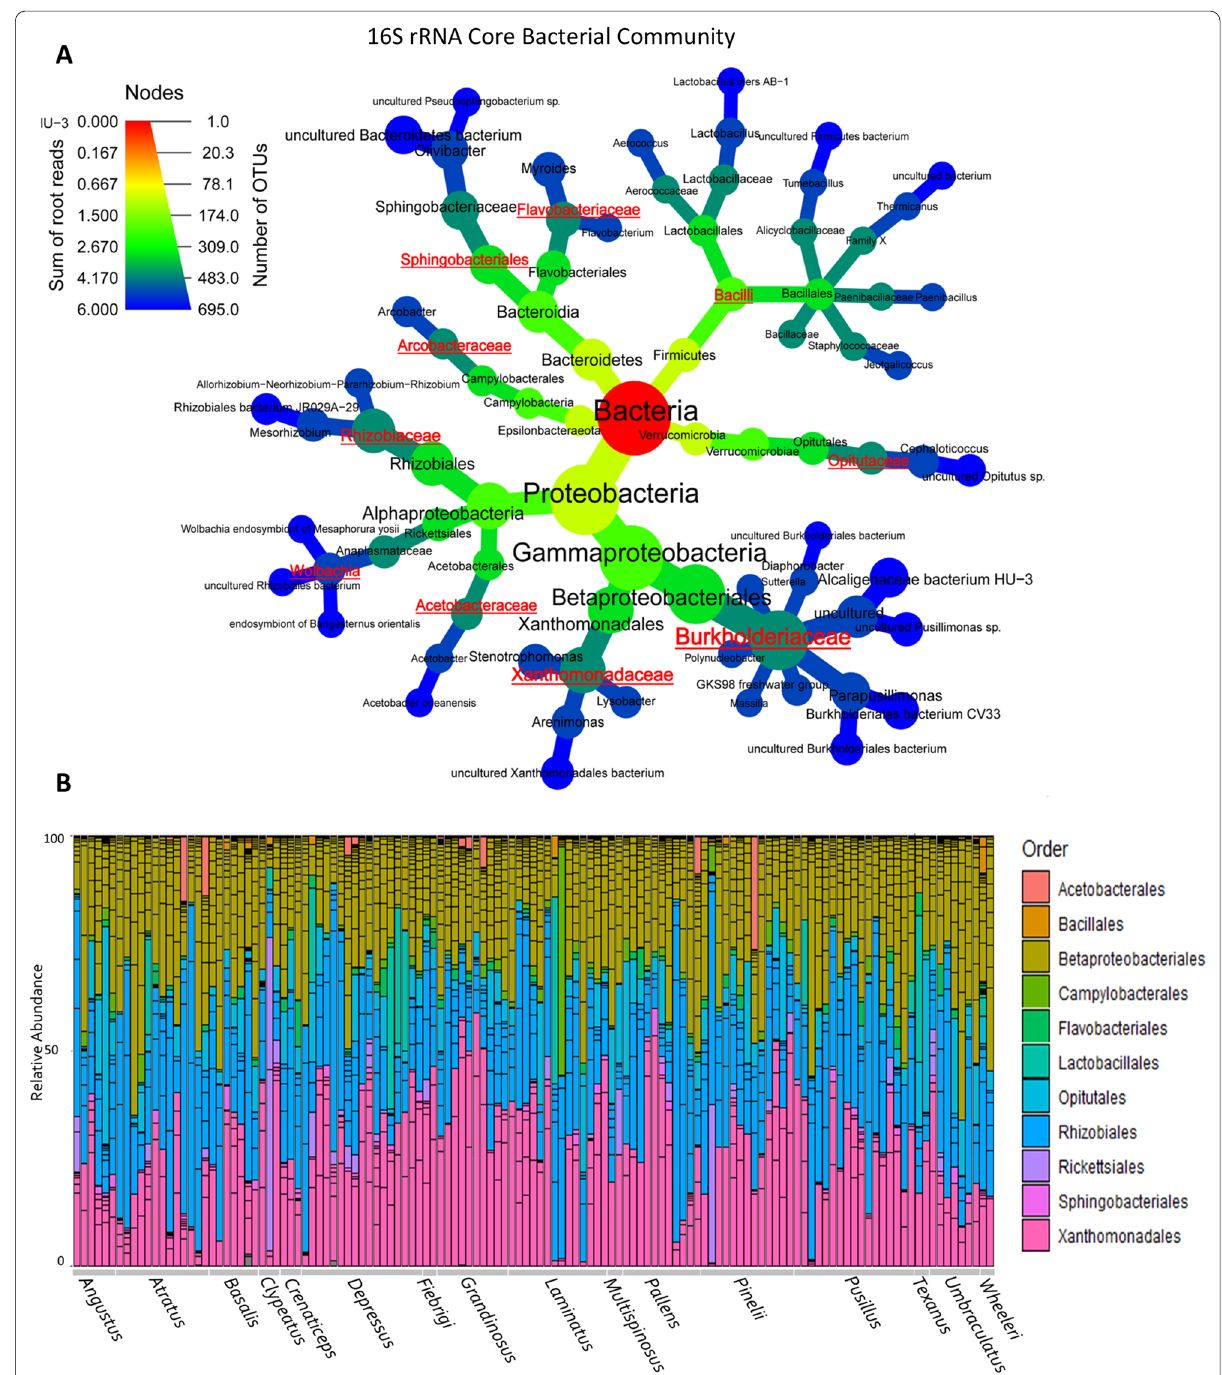
Fig. 1 Bacterial communities (16S rRNA) associated with turtle ants. A Heat tree phylogeny highlighting in red text the core bacterial community of Cephalotes from the present study. B Stacked barplots show the relative abundance of the bacterial order composition (16S rRNA) of each individual sample (column) with the host species group denoted along the